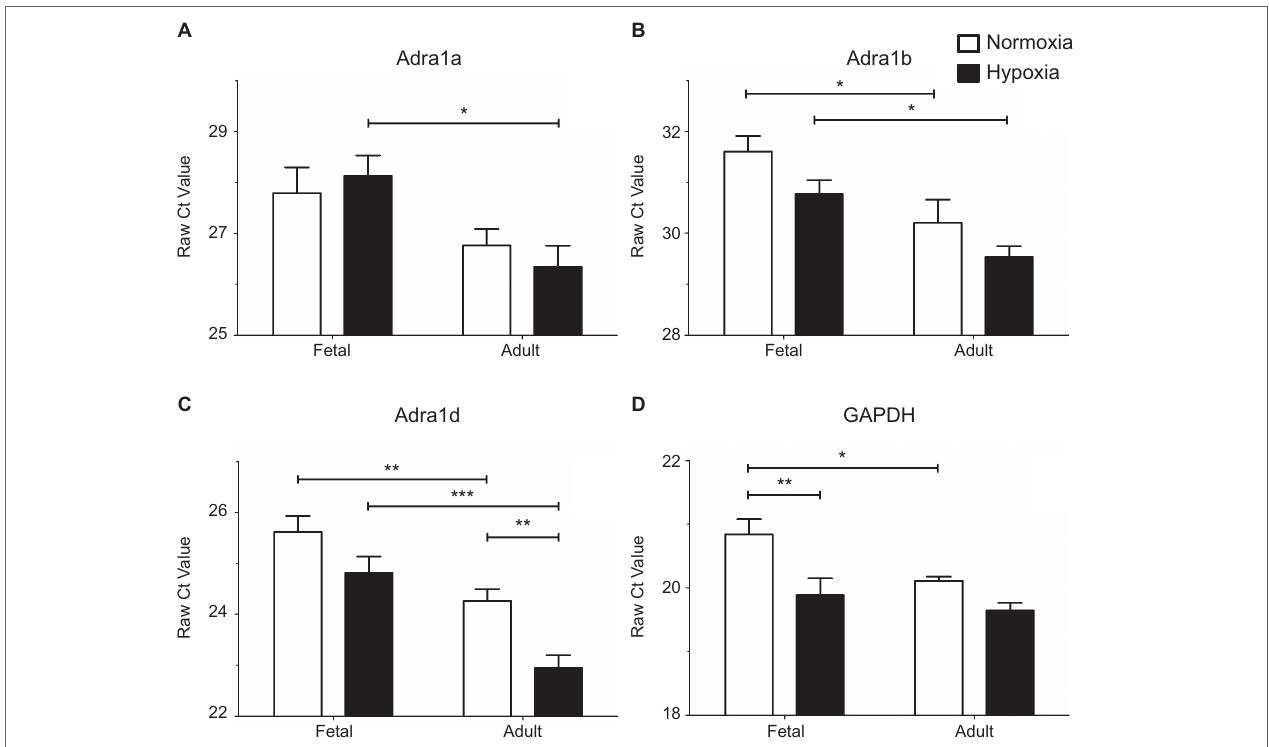
FIGURE 5 | LTH in the fetal and adult periods have unique impact on mRNA expression of alpha adrenergic receptors. Presented are the raw Cycle threshold (Ct) values from real time quantitative PCR measurements for (A) Alpha 1a AR, (B) Alpha 1b AR, (C) Alpha 1d AR, and (D) GAPDH. Normalization was to input RNA, all PCR reactions used input cDNA derived from 5 ng of total RNA. Bars and error bars represent the mean ± S.E.M. Significant differences between groups were established using a two-way ANOVA with a Bonferroni post hoc analysis (* p < 0.05, ** p < 0.01, *** p < 0.001). Numbers of animals for each group are provided in the methods